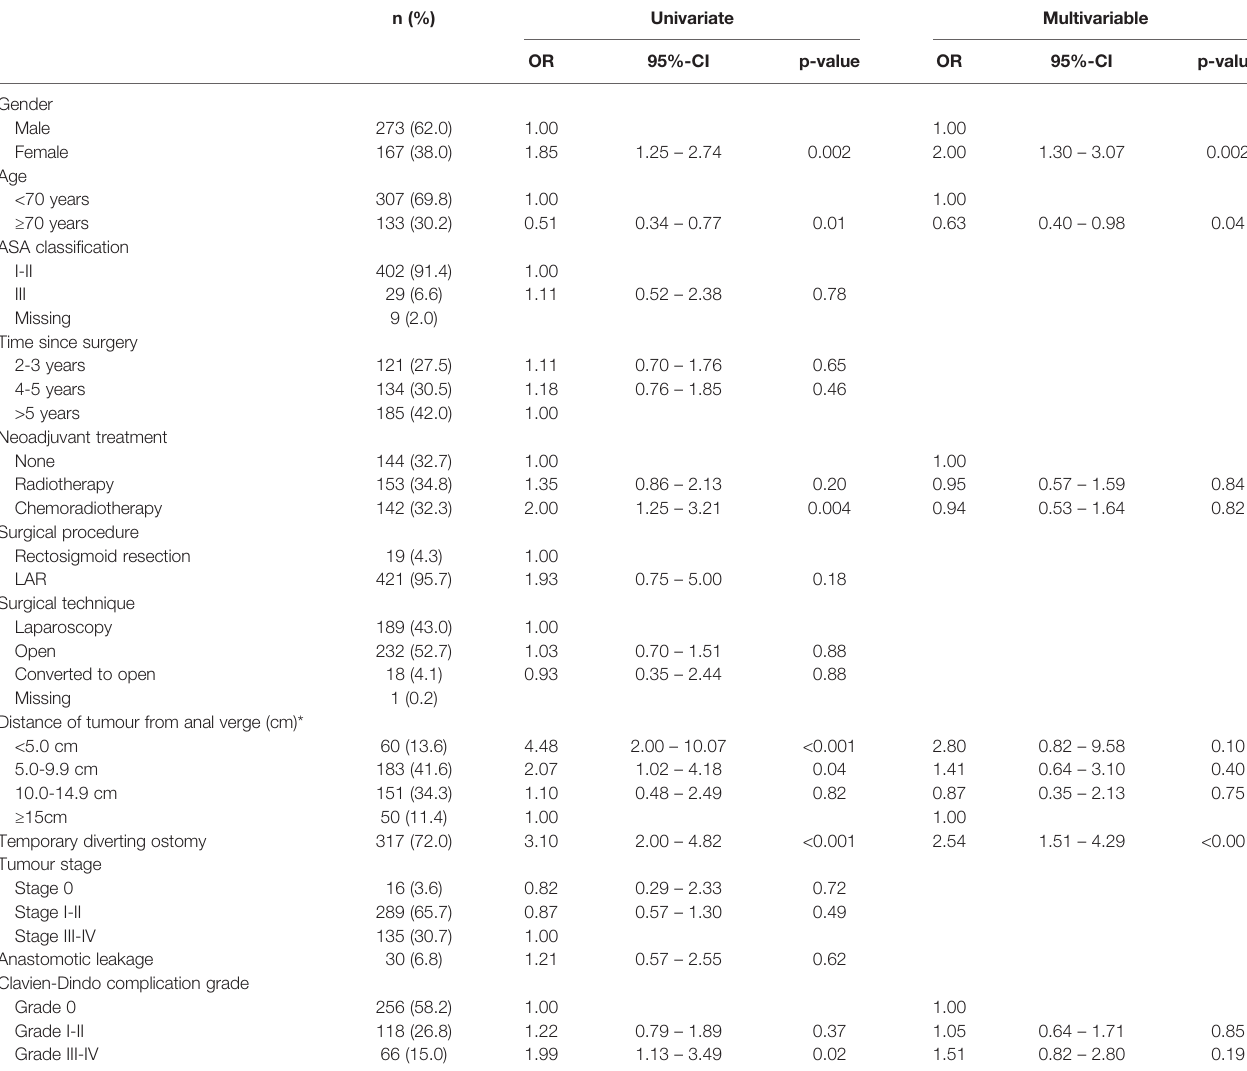
TABLE 3 | Univariable and multivariable logistic regression analyses on associated factors for major LARS in rectal cancer patients